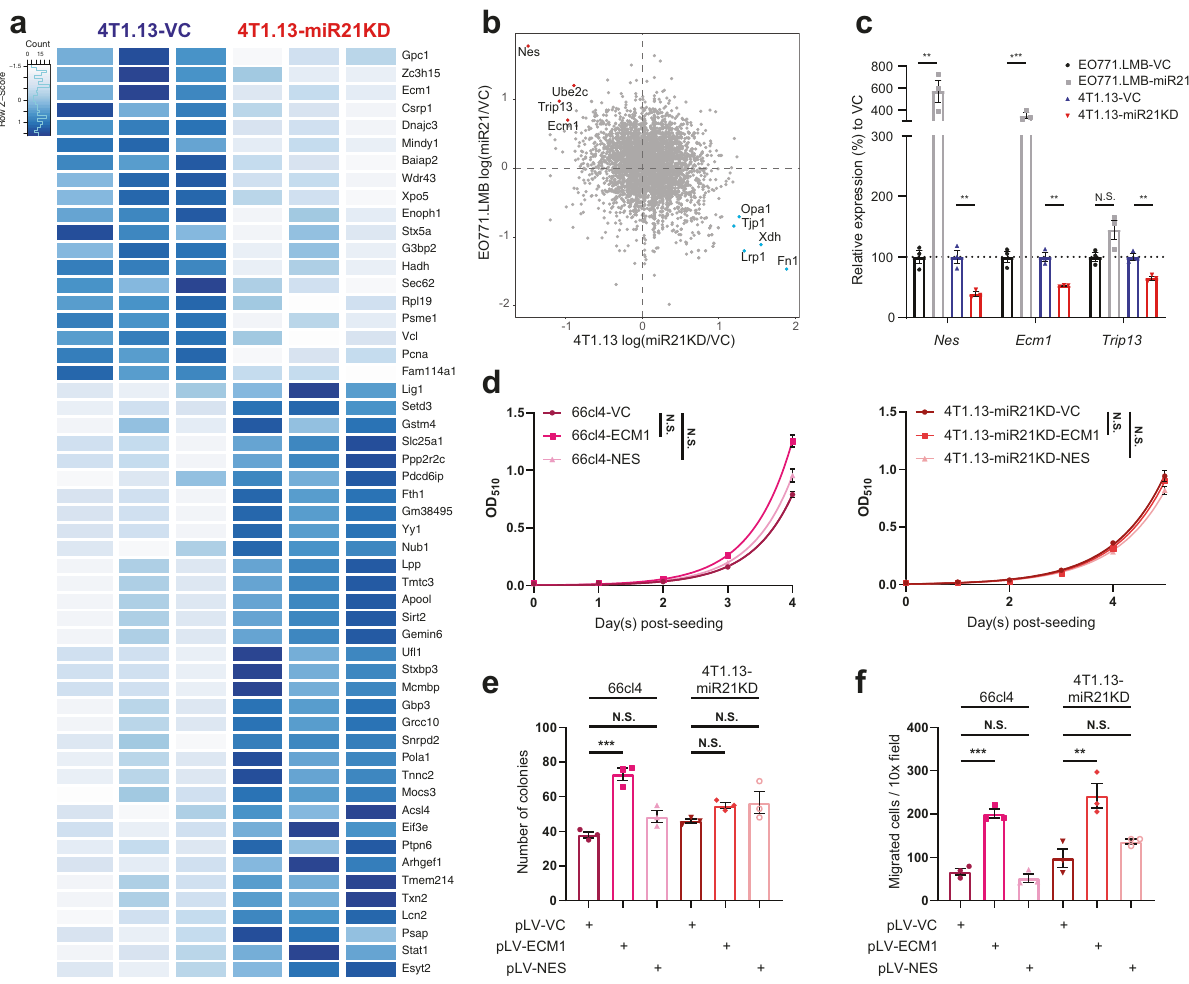
Fig. 6 Proteomic analysis by mass spectrometry of EO771.lmb and 4T1.13 cells following modulation of miR-21 levels or activity. a Heatmap of the top differentially expressed proteins in 4T1.13-miR-21-KD cells compared to 4T1.13-VC cells. b Commonly up-regulated (red, upper left) and down-regulated (blue, lower right) proteins by miR-21 in the 4T1.13 and EO771.LMB cells. c qPCR validation of miR-21 targets identi fi ed in the mass spectrometry analysis. Mean ± SEM ( n = 3). d Proliferation of 66cl4 and 4T1.13-miR-21KD cells with up-regulated expression of ECM1 or NES. Mean ± SEM ( n = 6/group). e Colony formation of 66cl4 and 4T1.13-miR-21KD cells with up-regulated expression of ECM1 or NES. Mean ± SEM ( n = 3/group). f Chemotactic migration of 66cl4 and 4T1.13-miR-21KD cells with up-regulated expression of ECM1 or NES. Mean ± SEM ( n = 3/group). ** p < 0.01; *** p < 0.001; N.S., not signi fi